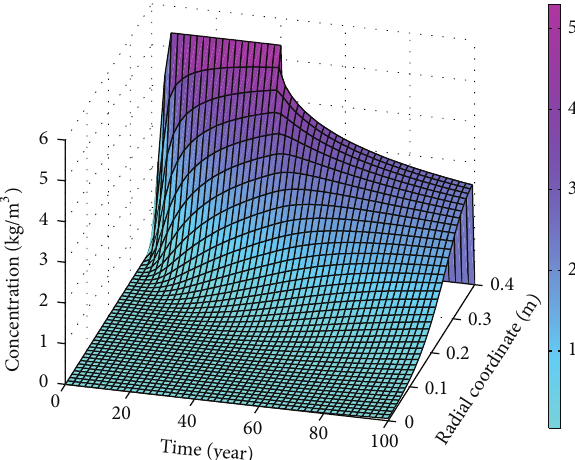
Figure 6: The evolution of chloride concentration with a sealing membrane applied at the outer surface of a concrete column, after 40 years. The surface chloride evolution and diffusivity assume the same conditions as those of Figure 4. A nominal thickness of 5 mm was reserved for the sealing membrane. 𝑅 = 0 . 4 m. 𝑤/𝑐 = 0 . 4.